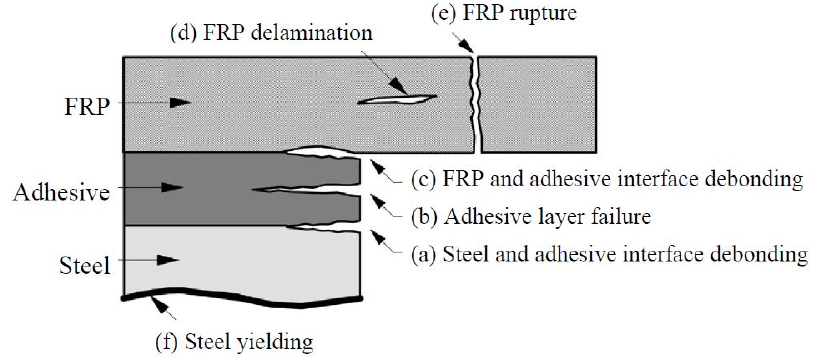
Figure 17. Possible failure modes of FRP bonded to steel